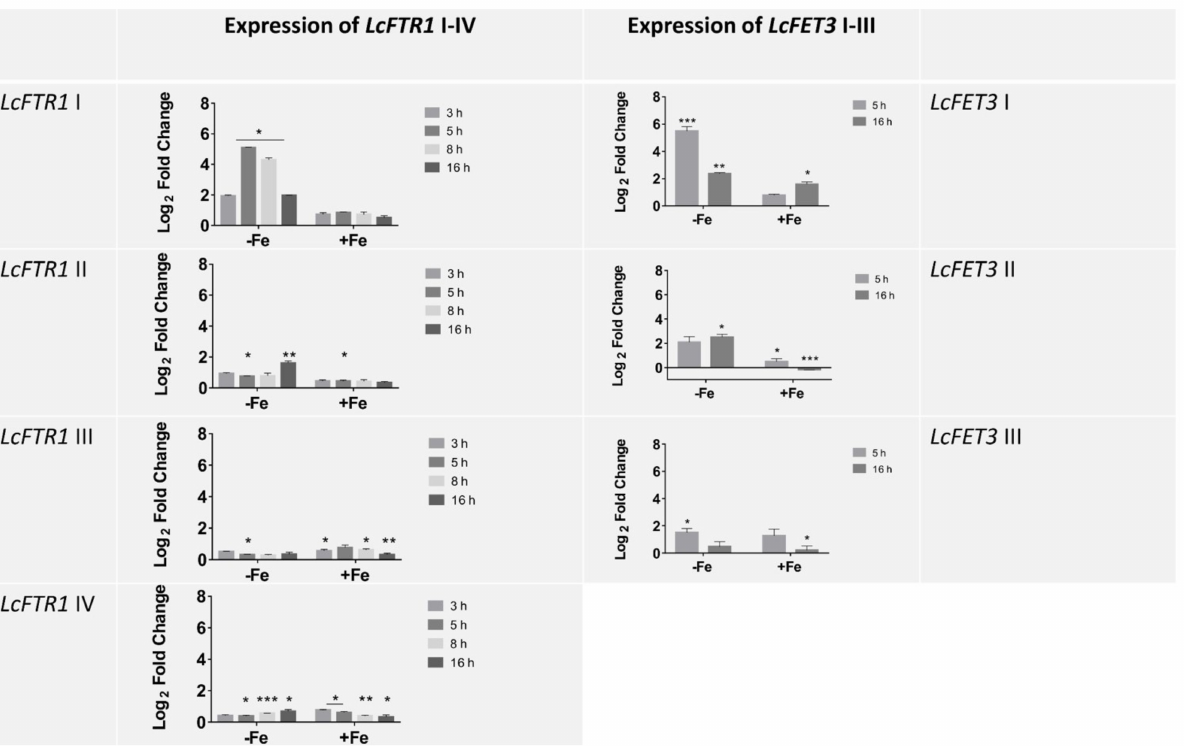
Figure 3. Expression profile represented as log 2 -fold change relative to the control condition of the putatively encoding L. corymbifera iron permeases ( LcFTR1 I-IV) and the partner ferroxidase LcFET3 ( LcFET3 I-II). Left panel: gene expression of the LcFTR1 I-IV under iron depleted, represented as −Fe (0.20 mM BPS) and iron stress simulated using (1.0 mM FeCl 3 . Expression represented as log 2 -fold change relative to each control condition. Right panel: gene expression of the LcFFET3 III for 5 h and 16 h under: iron depleted (0.20 mM BPS) and iron excess (1.0 mM FeCl 3 ) conditions; data are means and standard error of three independent experiments. Asterisks indicates statistical significance determined by Student’s t -tests comparing treatment and control conditions at each time point (* p < 0.05; ** p < 0.01; *** p < 0.001). Data are means and standard error of three independent